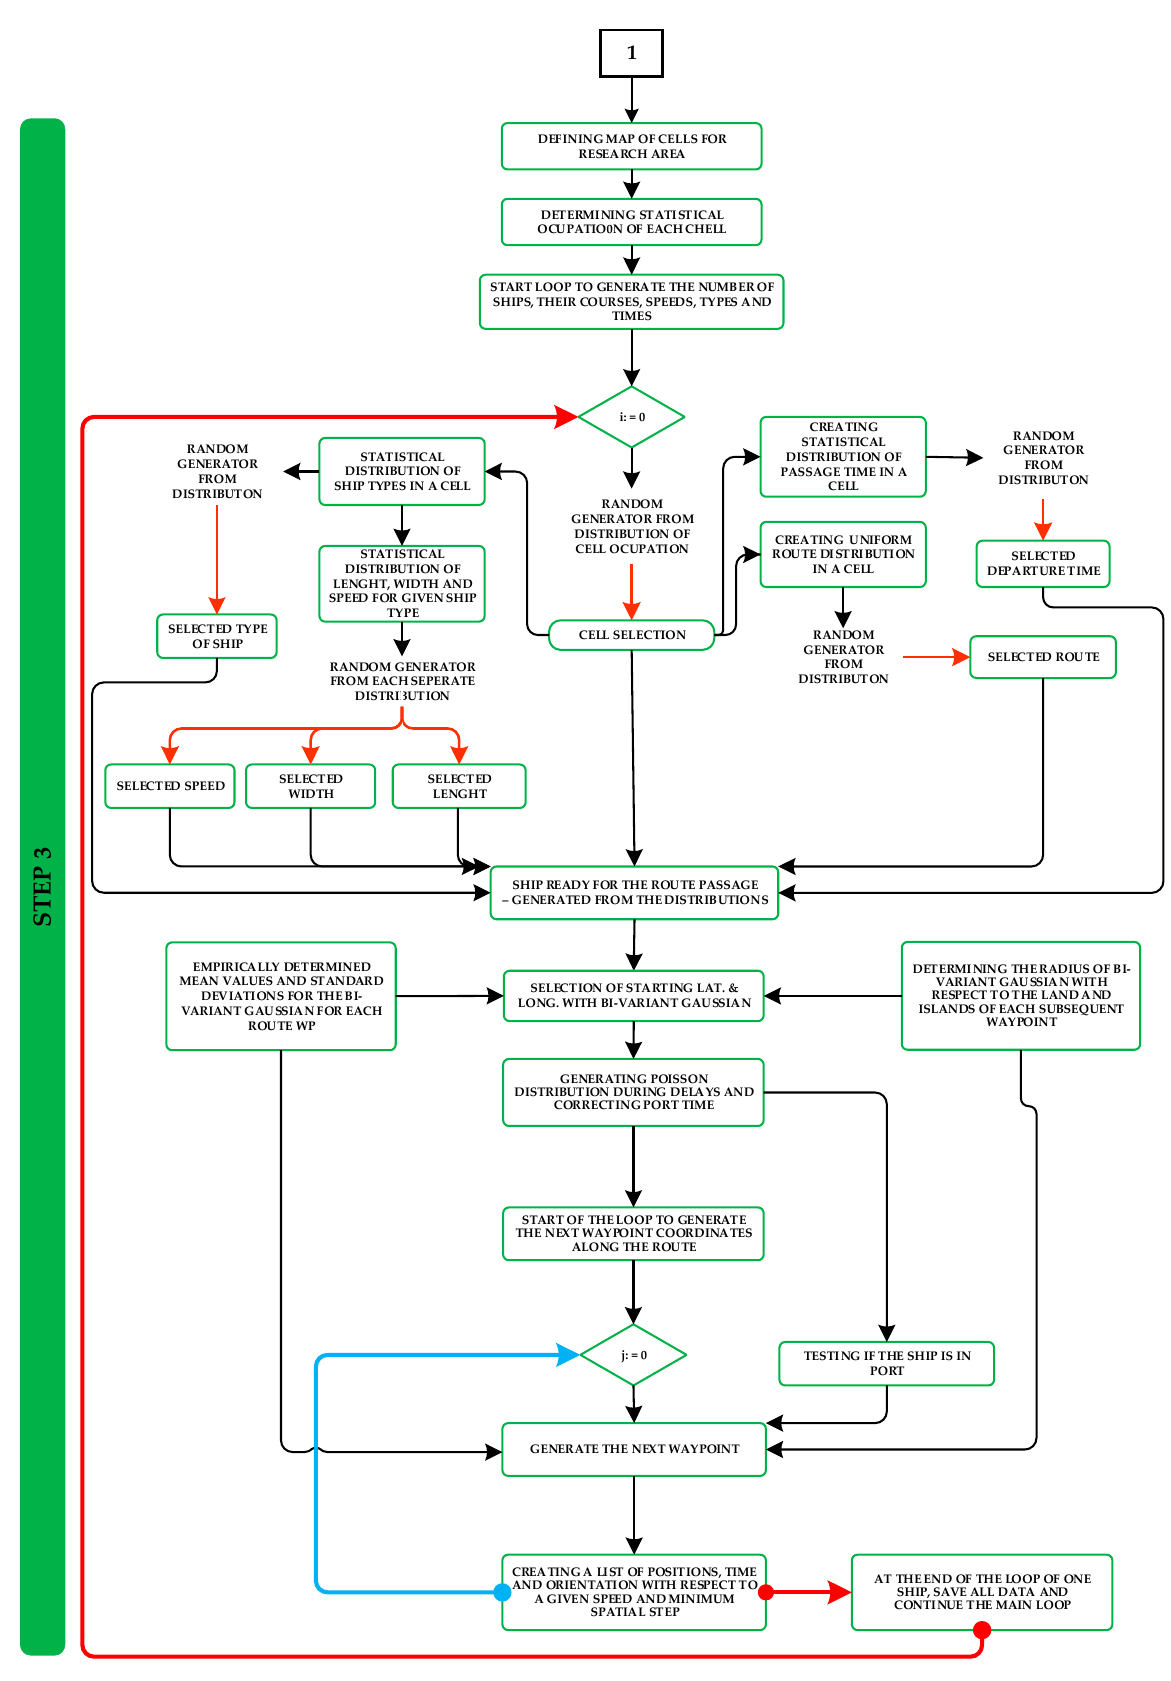
Figure 3. MC flowchart (Step 3).